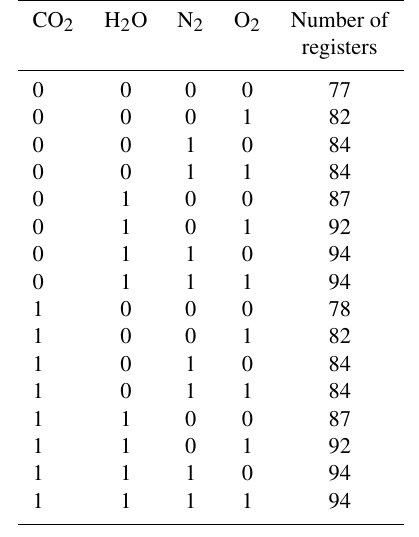
Table 1. Register counts for the 16 possible combinations of switch- ing on or off the CO 2 , H 2 O, N 2 , and O 2 continua in the GPU fusion_kernel as reported by the NVIDIA compiler ( nvcc v11.0.221) when compiling for an sm_70 architecture such as NVIDIA V100.